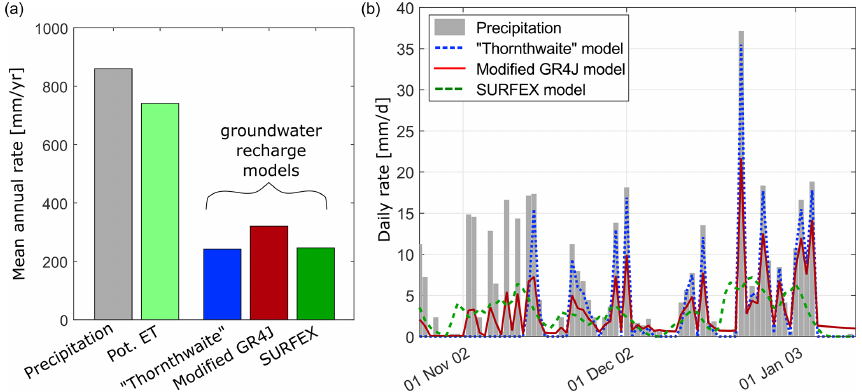
Figure 4. (a) Mean annual precipitation, potential evapotranspiration rate and estimated potential recharge rates from Thornthwaite, GR4J and SURFEX models on Ploemeur–Guidel sites (1996–2017). (b) Estimated daily potential recharge rates from Thornthwaite, GR4J and SURFEX models from November 2002 to January 2003. Daily precipitation (gray shaded bars) is recorded by a METEO-FRANCE weather station and is used to derive recharge from Thornthwaite and GR4J